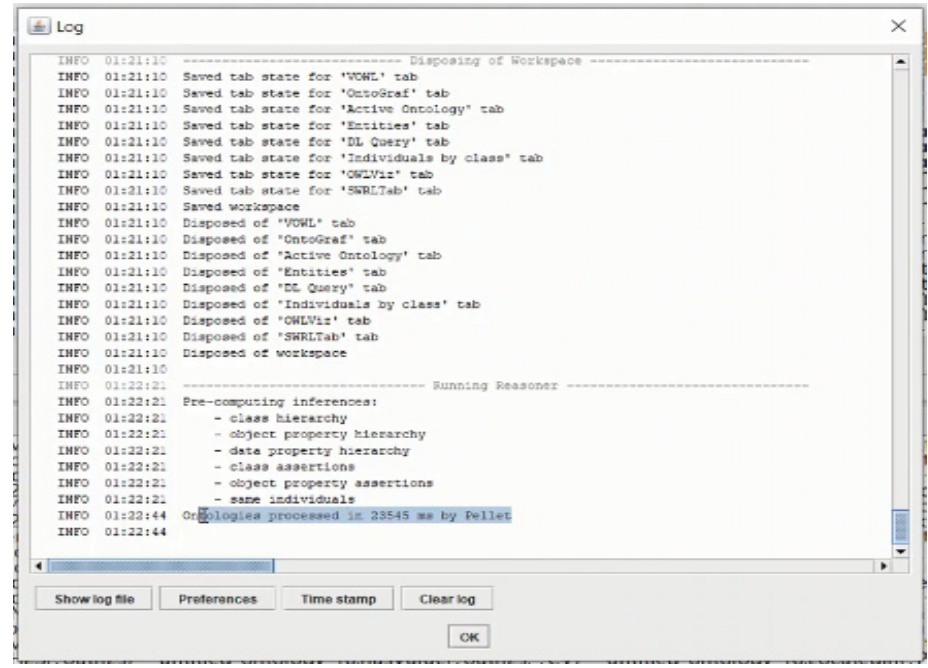
Figure 8. Execution time for entire rules engine, ontologies processed in 23,545 ms.